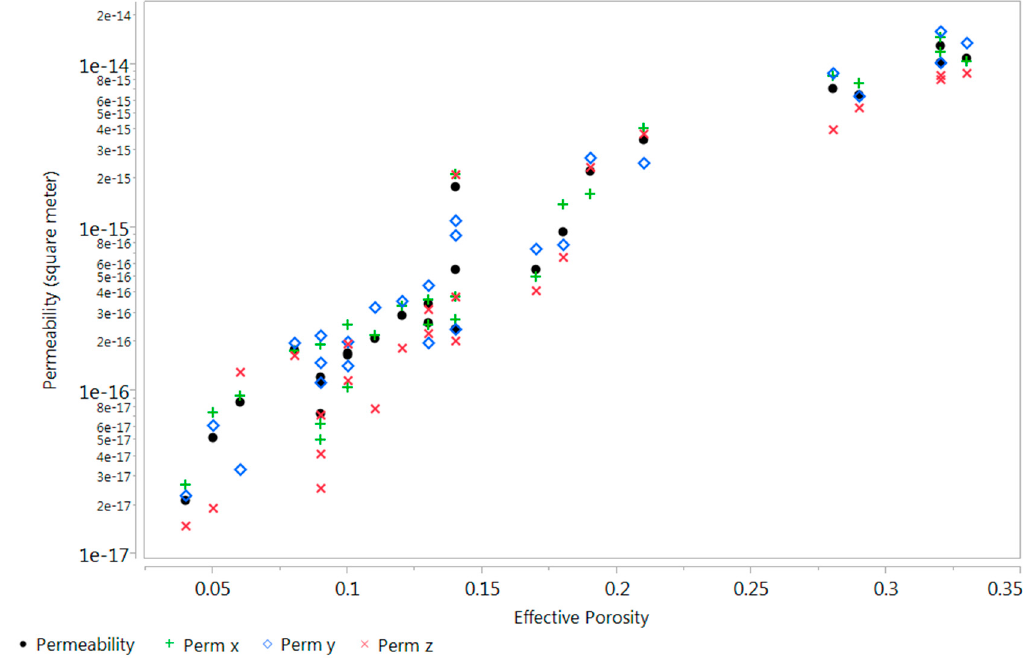
Figure 9. Scatter plot between effective porosity and intrinsic permeability (m 2 ).